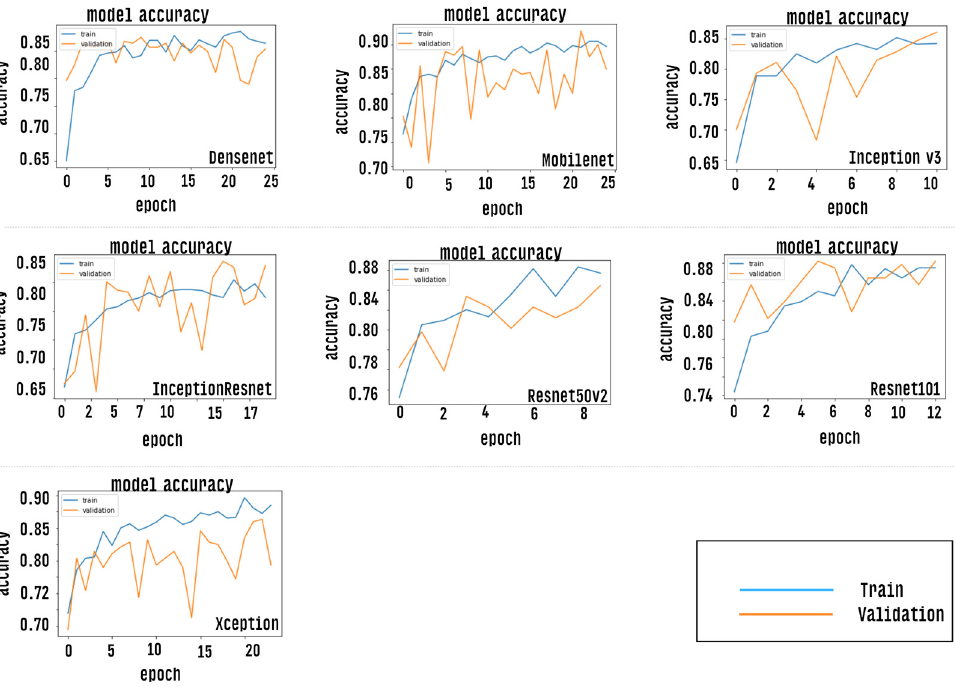
Figure 9. Shows an accuracy curve indicating the performance for each trained CNN model.